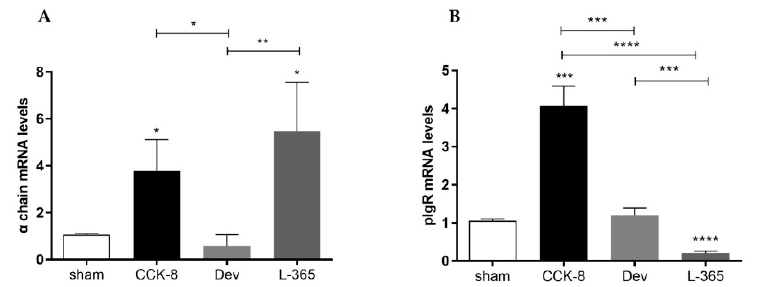
Figure 3. Relative mRNA expression of α chains in lamina propria cells ( A ) and pIgR in epithelial cells isolated from the small intestine ( B ) of sham-, CCK8-, devazepide- and L365,260-treated mouse groups. The results from one representative experiment (from three replicates) with eight mice per group are expressed as the mean and standard deviation (SD). * p < 0.05, ** p < 0.01 *** p < 0.001 and **** p < 0.0001 upon column comparisons vs. control group or upon line comparisons among the CCK8, devazepide and L365,260 groups.